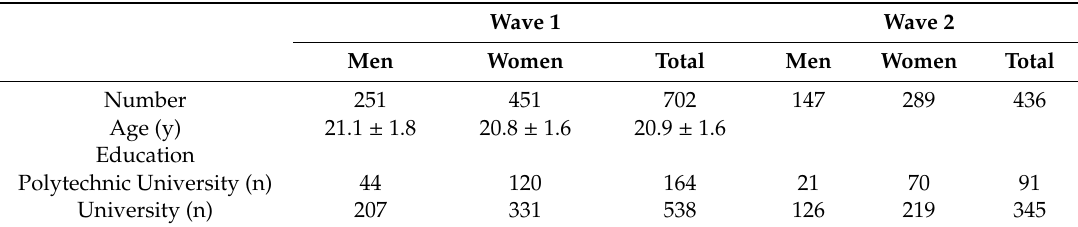
Table 1. Population characteristics of participants in Wave 1 and Wave 2.